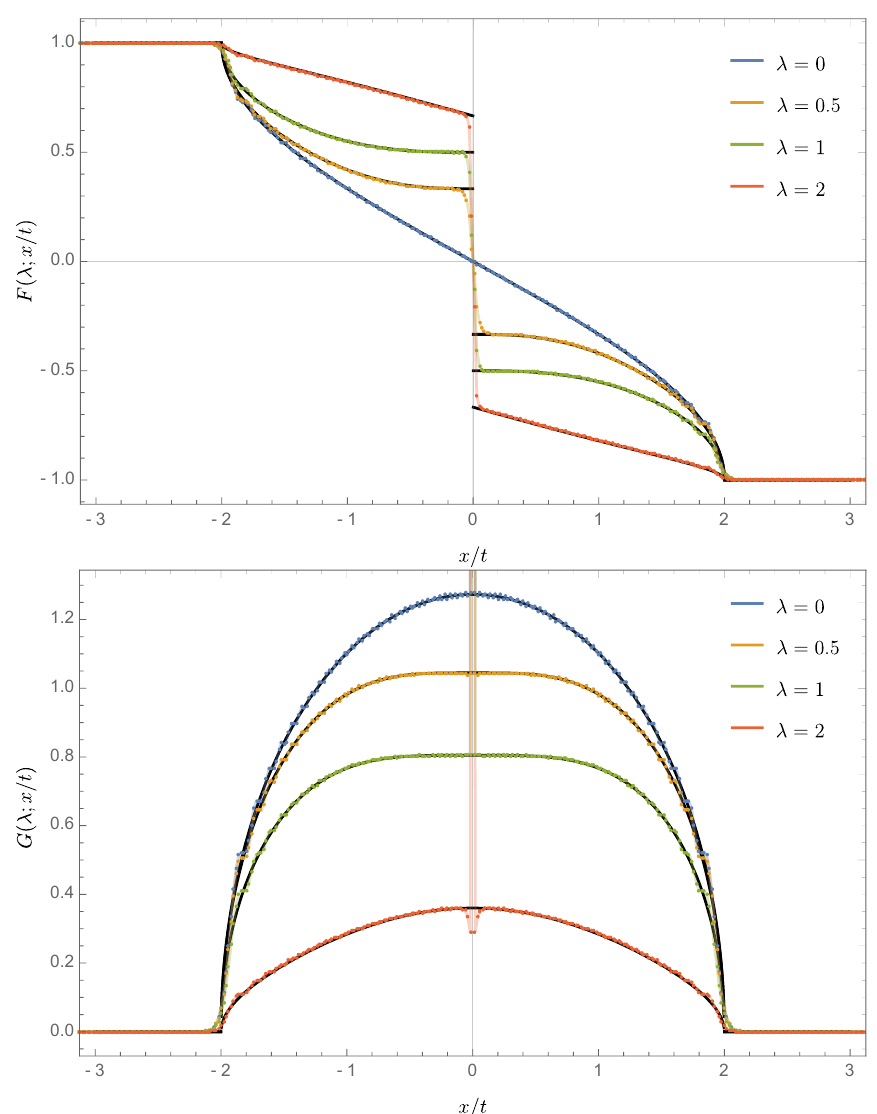
Figure 8: Asymptotics of the density n ∞ ( x / t ) ( top ) and current J ∞ ( x / t ) ( bottom ) for a density defect as given by the corresponding scaling functions F ( λ ; x / t ) = − ( n ∞ ( x / t ) − ν ) /µ and G ( λ ; x / t ) = − J ∞ ( x / t ) /µ respectively for dif- ferent values of the defect strength λ ≥ 0. Coloured lines and points: numerical data at the maximum time reached ( t = 50), black lines: analytical expressions from (57) and (58) with R ( k ) given by